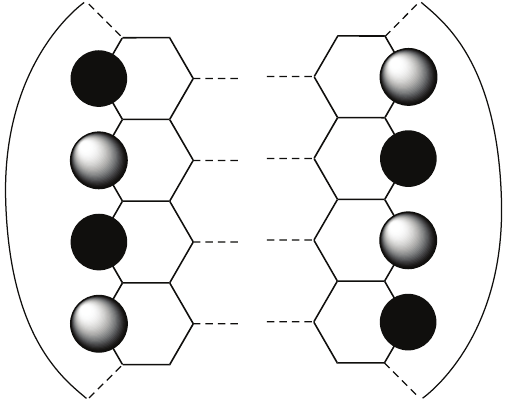
Table 1: The various ground state energy levels and their occupation numbers (STO-3G basis set) for the four different classes of nanotubes along with their true symmetries. It is interesting to note the abelian groups of each class: class I (6 4) = 𝐶 2 V ; class II (6 5) = 𝐷 2ℎ ; class III (7 5) = 𝐶 (7 4) = 𝐶 2ℎ ; class IV 2 V . Symmetry group Nanotube of the nanotube